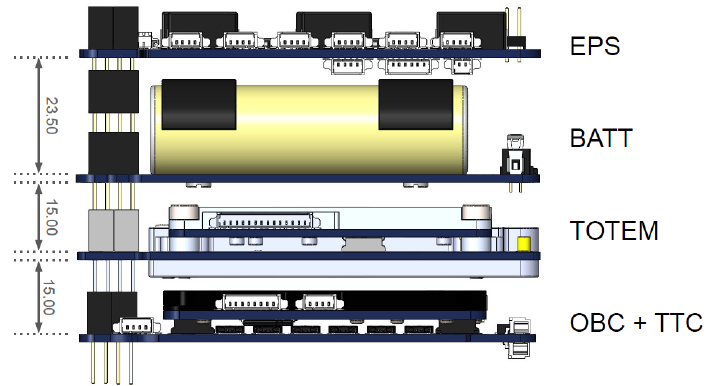
Figure 4. AlfaCrux